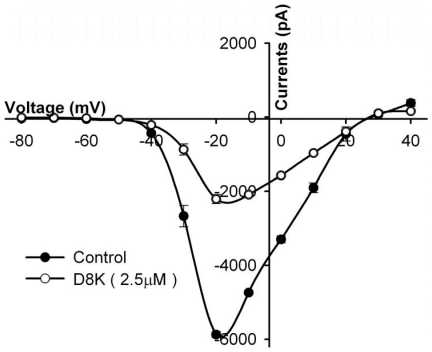
The current - voltage (I–V) relationship of D8K on TTX-R currents.
I–V relationships of TTX-R currents before (filled circles) and after (open circles) the treatment of 2.5 µM D8K, respectively. Cells were held at −80 mV, and TTX-R currents were elicited by 50 ms depolarizing steps to various potentials ranging from −80 mV to +40 mV in 10 mV increments. Only D8K is presented here for example.